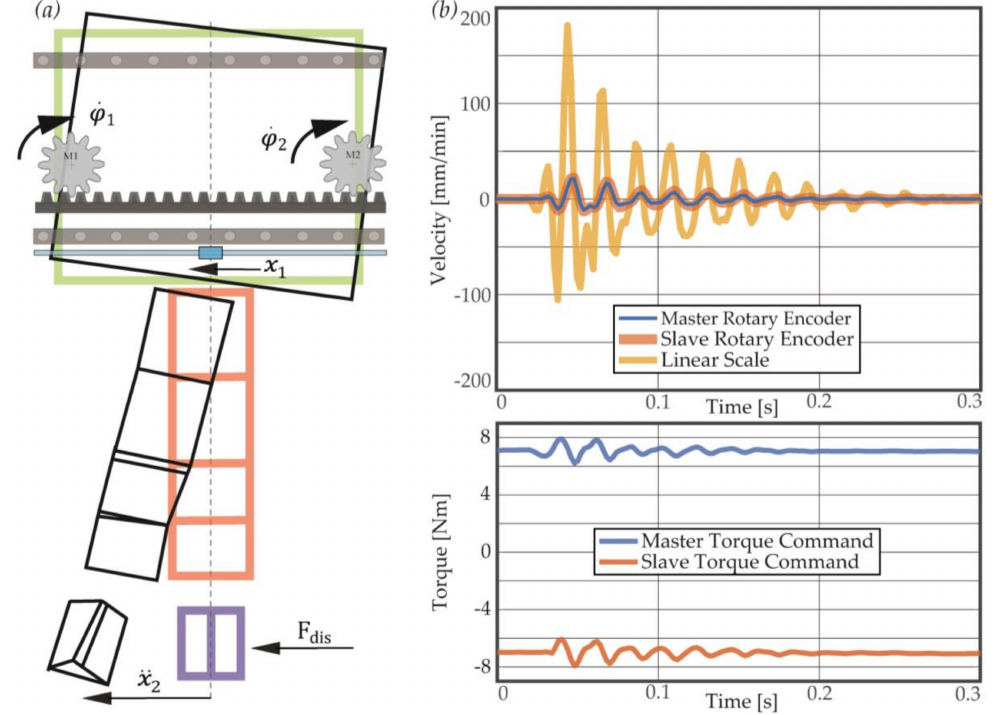
Figure 5. ( a ) Modal shape deformation detail, ( b ) Velocity and Torque CNC internal variables reaction to